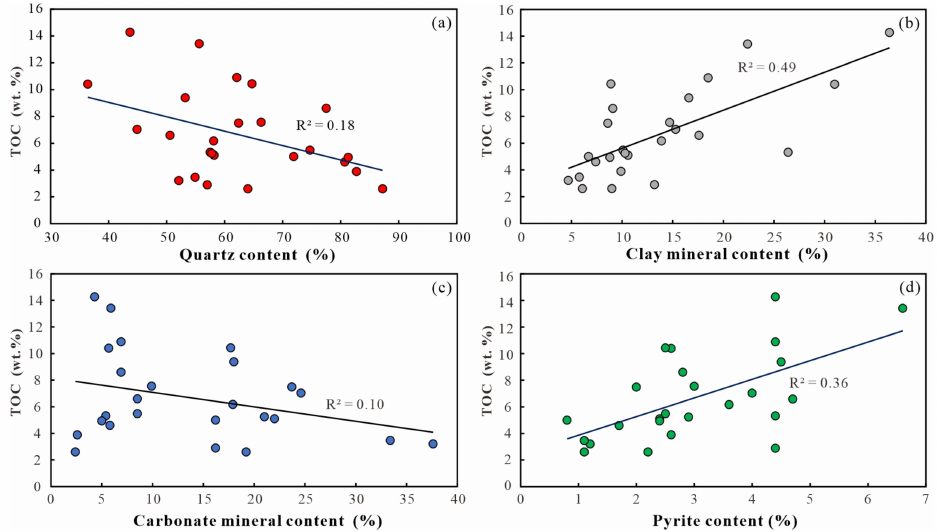
Figure 6. Correlations between TOC content and ( a ) quartz, ( b ) clay mineral, ( c ) carbonate mineral, and ( d ) pyrite contents in the Dalong Formation